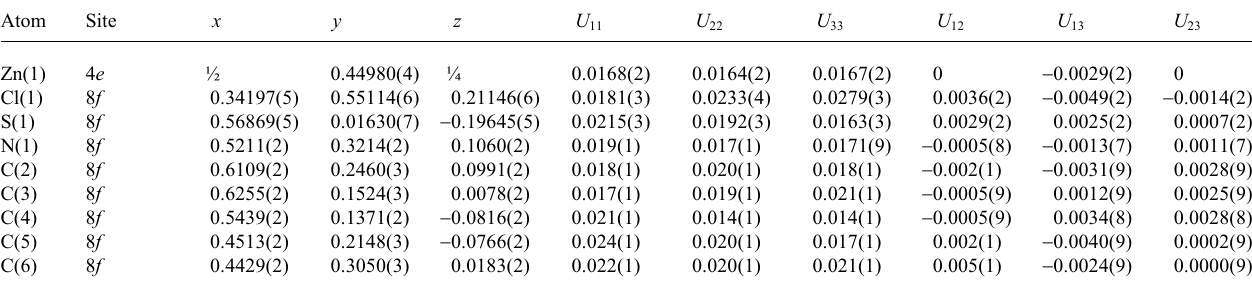
Table 3. Atomic coordinates and displacement parameters (in Å 2 ) .